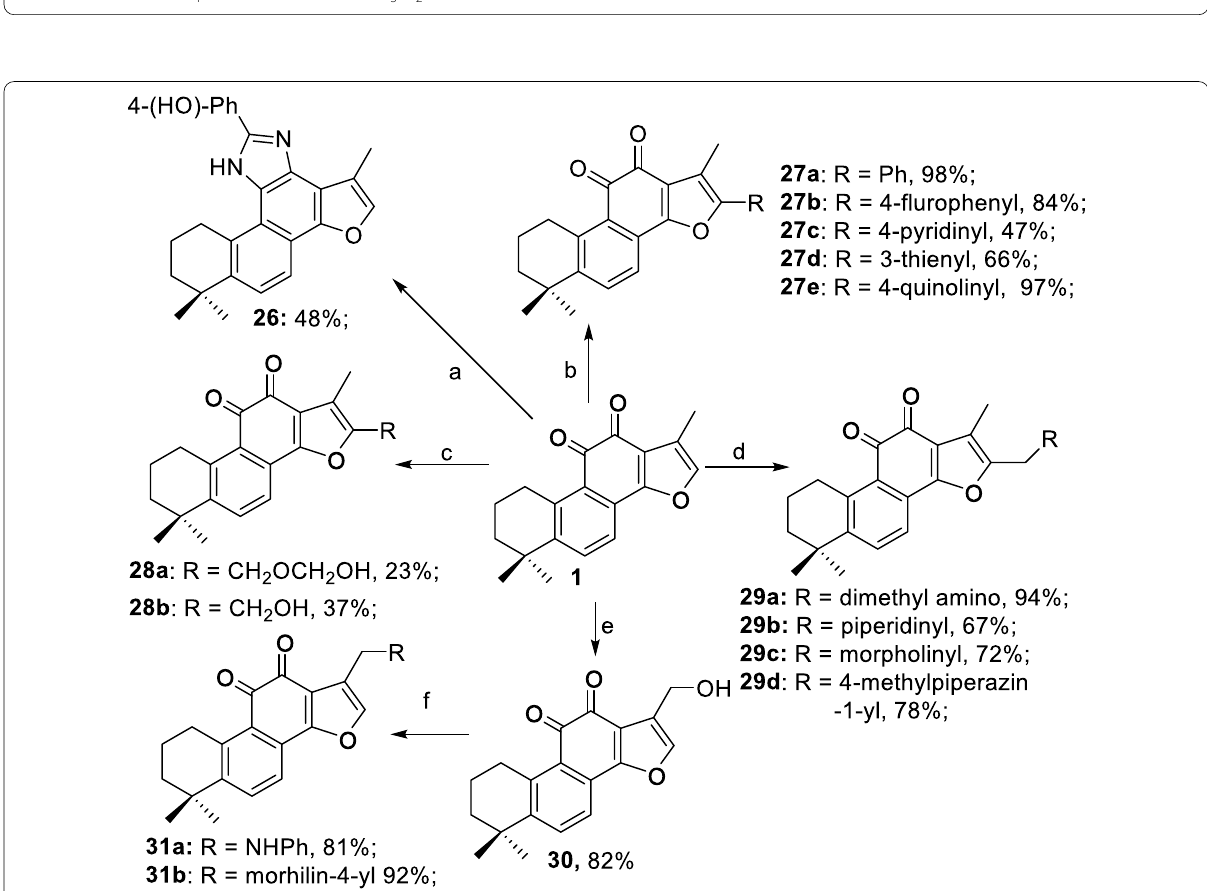
Scheme 4 Modifications on C‑ and D‑rings of 1 . Reagents and Conditions : a) p ‑Hydroxybenzaldehyde, ammonium formate, AcOH, 100 o C; b)